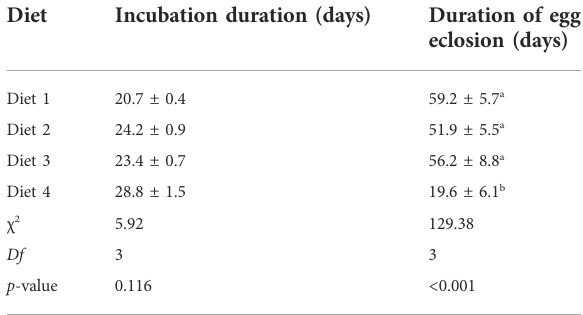
TABLE 6 Mean (±SE) incubation and egg eclosion duration of Ruspolia differens raised on different diets.